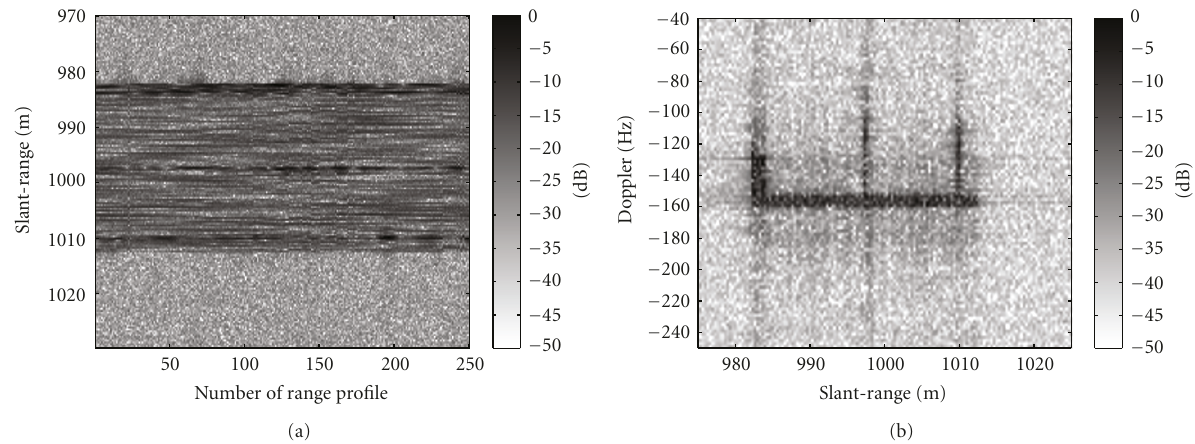
Figure 7: (a) Range profiles and (b) reconstructed ISAR image after applying the proposed subinteger range-bin alignment method to the simulated data with translational motion.